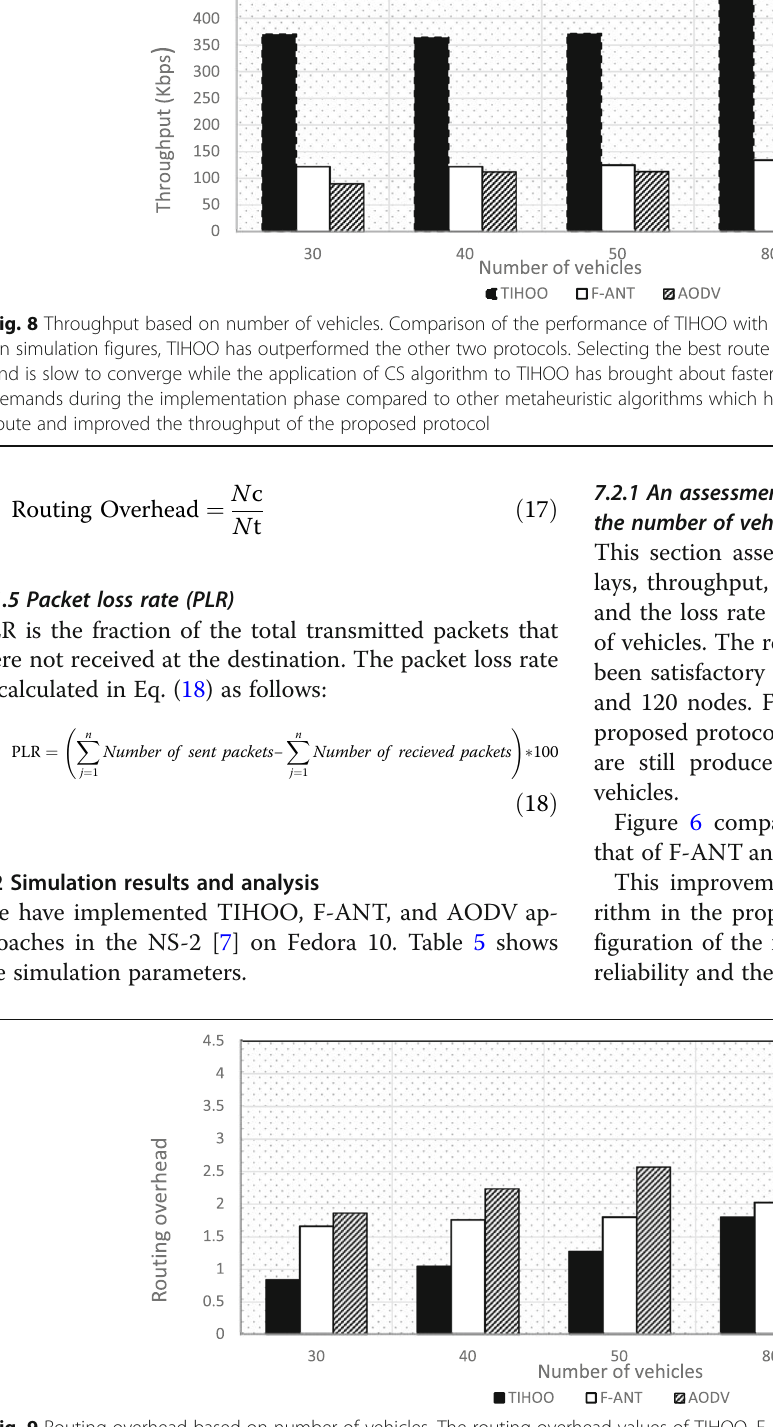
Fig. 9 Routing overhead based on number of vehicles. The routing overhead values of TIHOO, F-ANT, and AODV for various numbers of vehicles. In TIHOO, broadcasting of route request control packets are prevented and the discovery is conducted in a controlled manner while running this phase in AODV algorithm causes increased system overhead. Also, F-ANT protocol imposes increased overhead on the system as a result of employing the ACO metaheuristic algorithm and storing the whole information of the entire colony. Therefore, TIHOO outperforms other protocols in terms of overhead produced